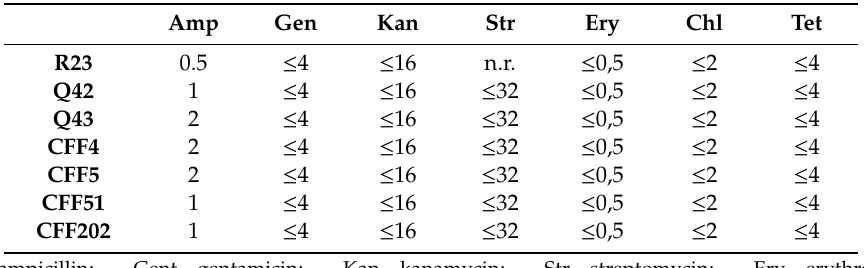
Table 2. Minimum inhibitory concentrations (MIC; µ g / mL) of seven antibiotics for seven lactic acid bacteria (LAB) isolates.